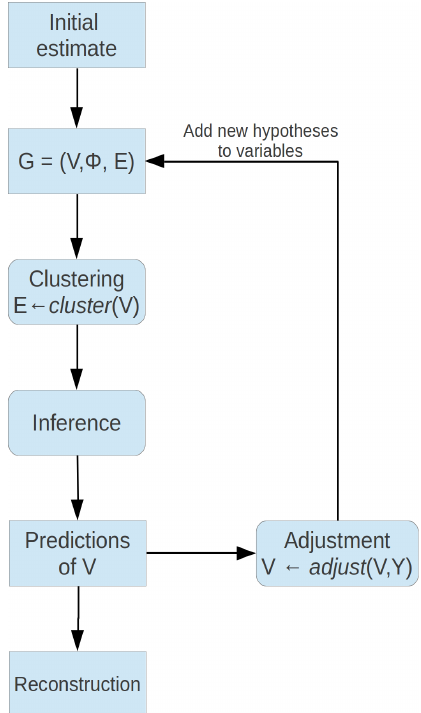
Figure 4: Workflow of the presented approach. The computa- tion is divided into global and local parts. Whereas the inference computes the MAP based on the global parametrization of the graph G , the adjustment performs only a local operation based on the predicted states on the variables V and the corresponding observations Y . The iterations continues until a stop criterion is reached but in our experiments the number of iterations was fixed and chosen to be large enough.